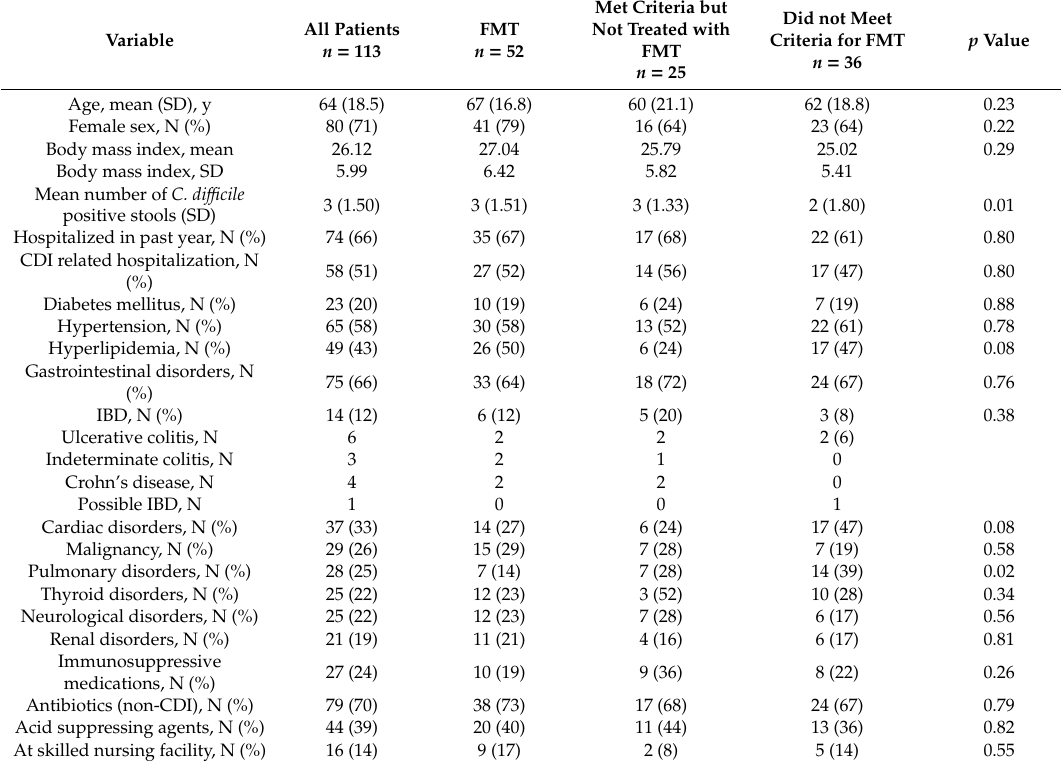
Table 3. Demographics of patients seen in the complicated C. di ffi cile clinic.